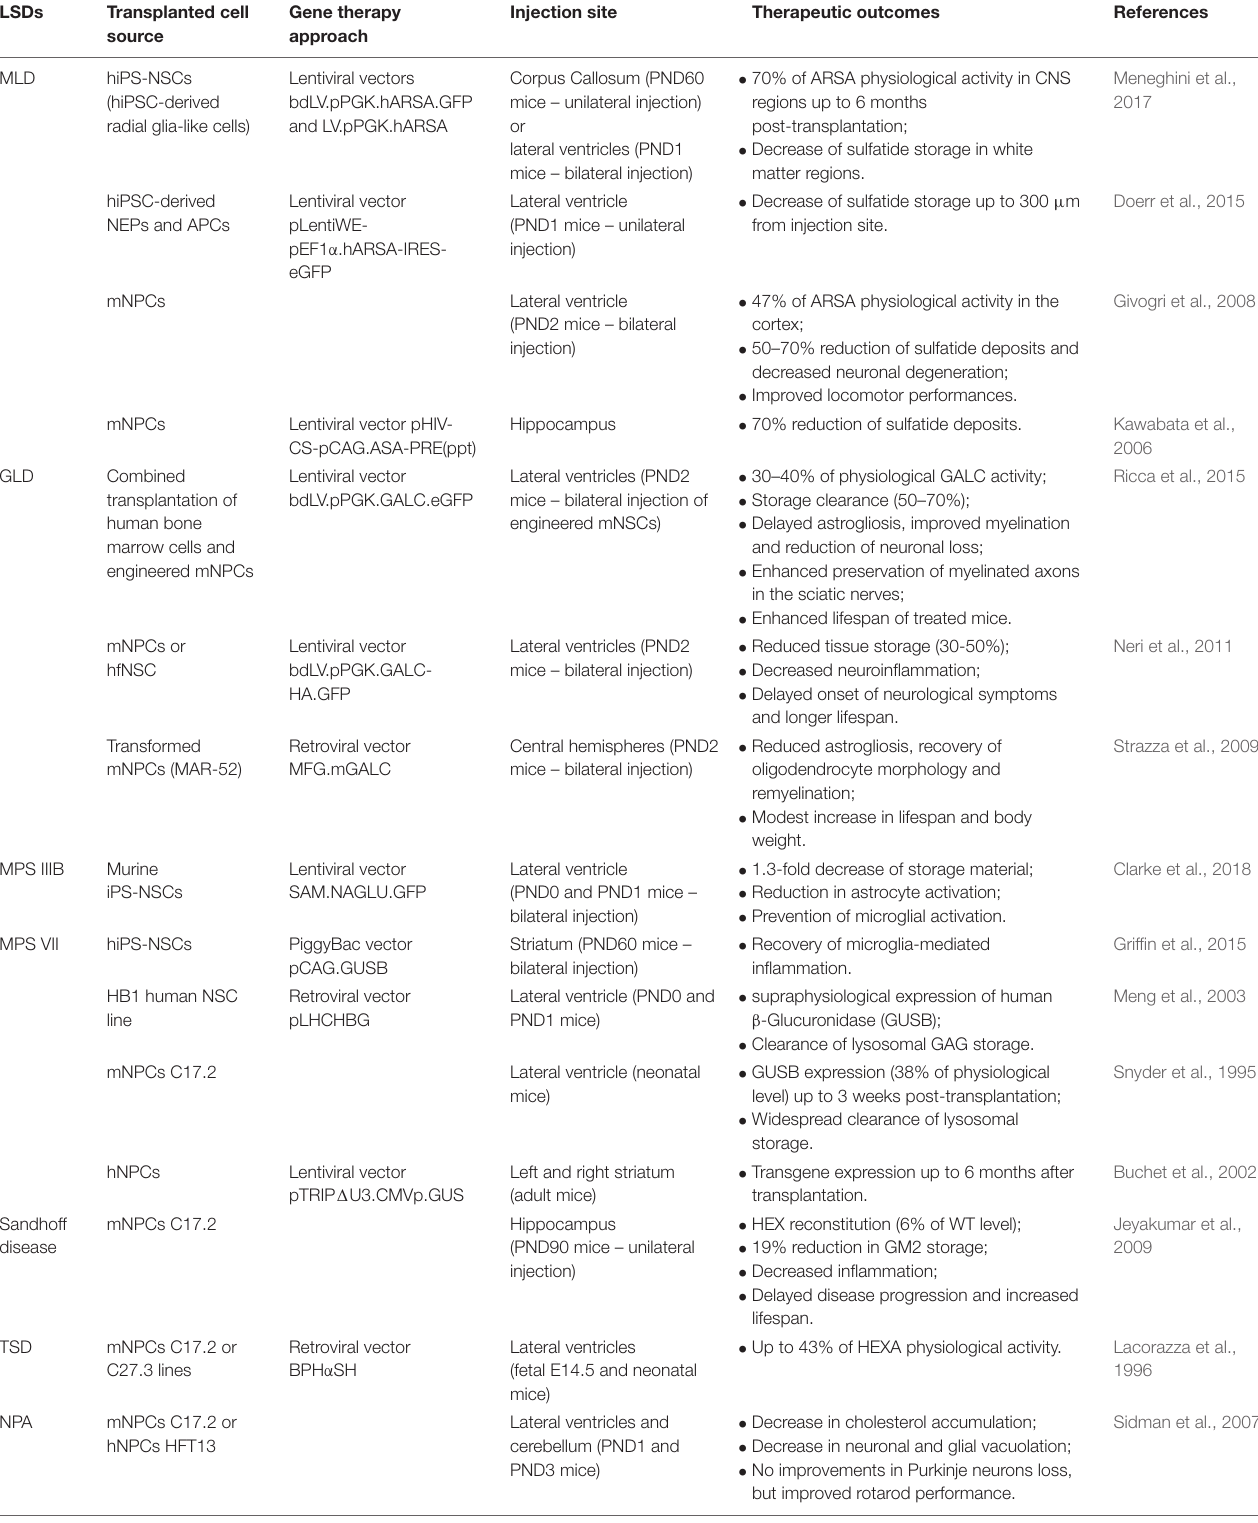
TABLE 2 | Summary of pre-clinical cell therapy approaches based on human and murine neural stem/progenitor cells for the treatment of neurodegenerative